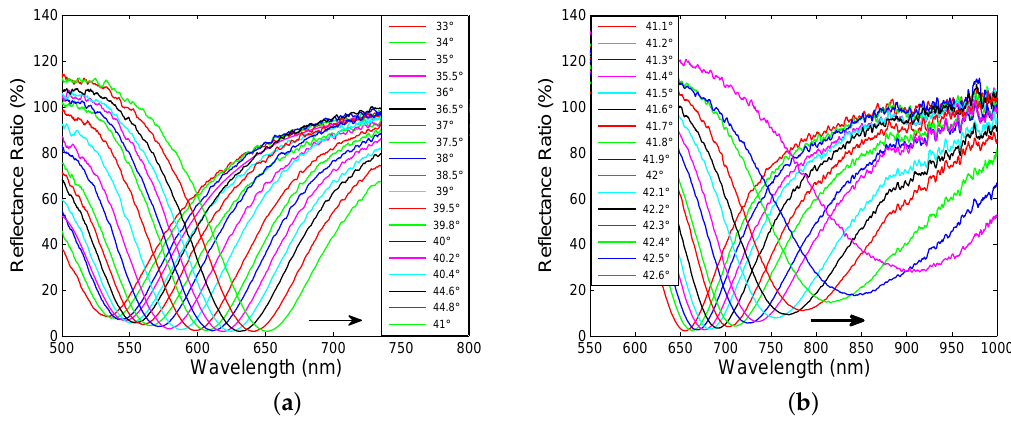
Figure 4. Measured reflectance ratio R p ( λ ) / R s ( λ ) as a function of the wavelength for different angles of incidence α : 33 ◦ to 41 ◦ ( a ), 41.1 ◦ to 42.6 ◦ ( b